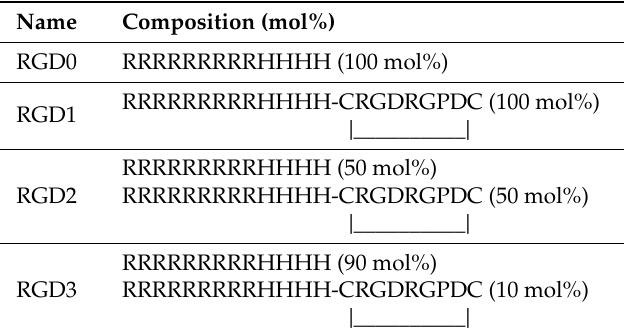
Table 1. Design of the